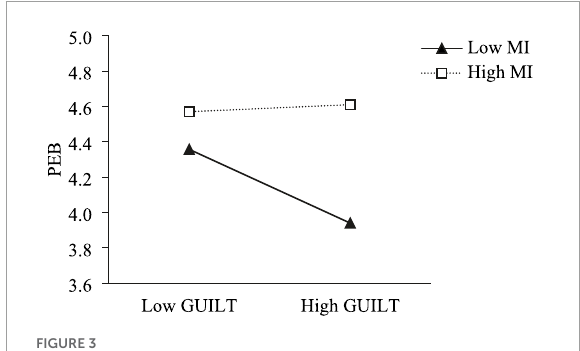
FIGURE3 Moderating effect of moral identity on the relationship between guilt and pro-environmental behavior.